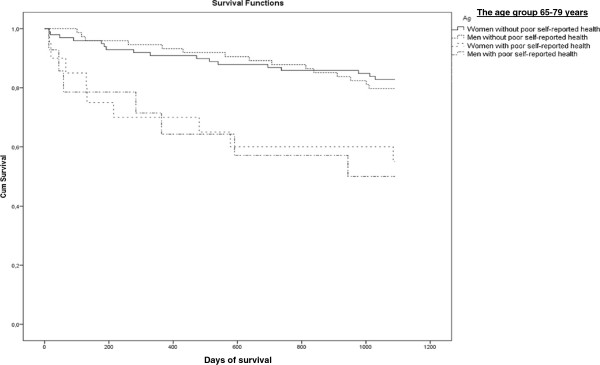
Kaplan-Meier plot: Days of Survival up to 3 Years (1096 days) in the Age group 65–79 years by Gender and with or without poor Self-reported Health.